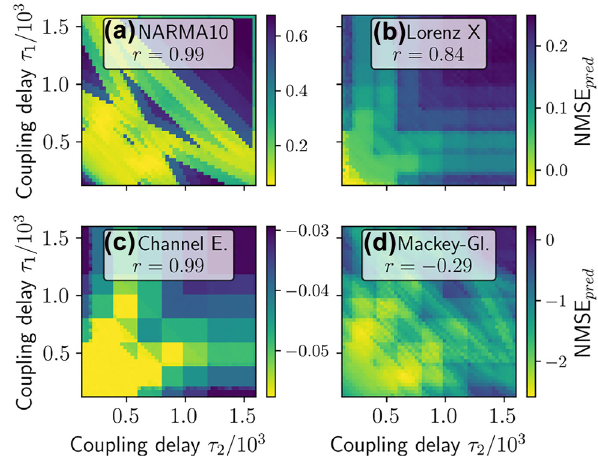
Figure 6: Predicted performance (NMSE) in parameter space for different tasks: (a) NARMA10, (b) Lorenz X, (c) Channel equalization and (d) Mackey–Glass tasks as a scan over the delays in the ring-coupled system of Figure 2a as determined using Eq. (14). (a–c) Insets give Pearson correlation coefficients r to the computed errors in Figure